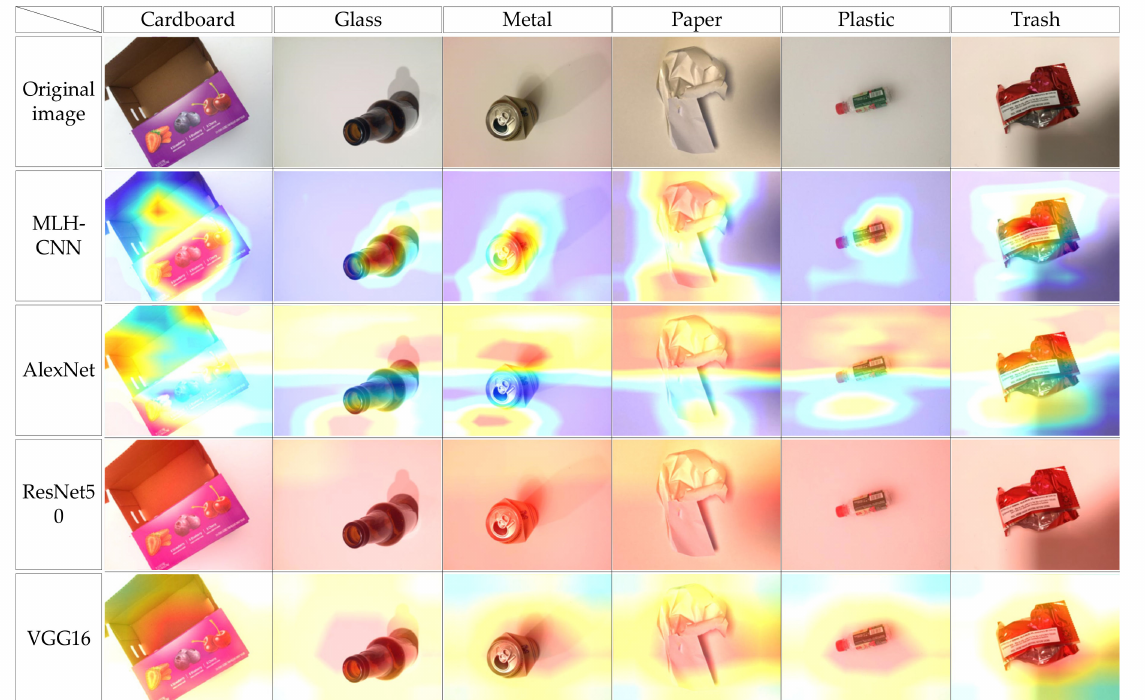
Figure 10. Comparison of heat map results of different